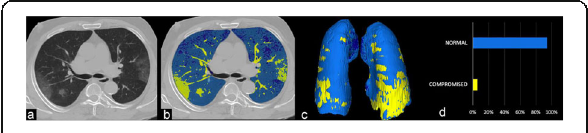
Fig. 1 (abstract A182). Quantitative lung CT analysis of an 81-year- old male patient affected by COVID-19. Example of Residual Ventilated Lung